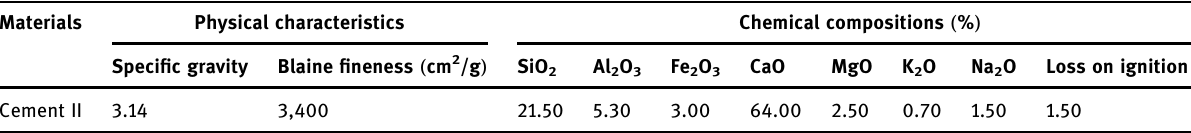
Table 1: Physical characteristics and chemical compositions of Portland cement II Materials